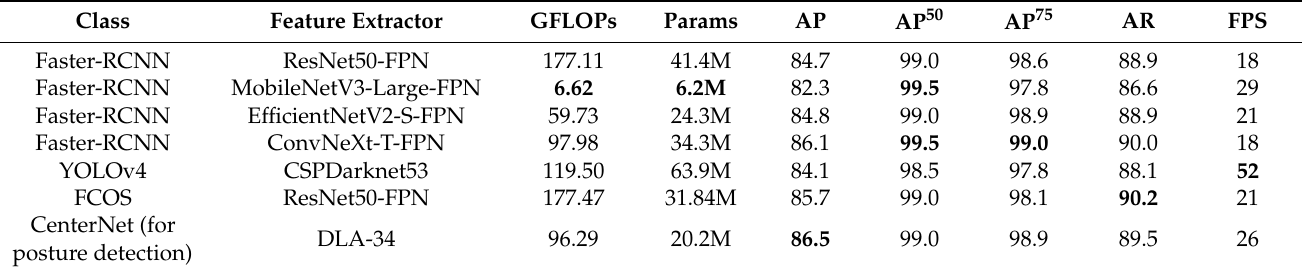
Table 3. Results of different object detection models on the pig posture test set. GFLOPs represent the computational effort of the model; Params represent the number of parameters; AP 50 and AP 75 are the average precision when the intersection over union (IOU) threshold is set to 0.5 and 0.75. AP and AR are average precision and average recall averaged over 10 IOU threshold (0.50:0.05:0.95); FPS represents the inference speed. The best results are in bold.